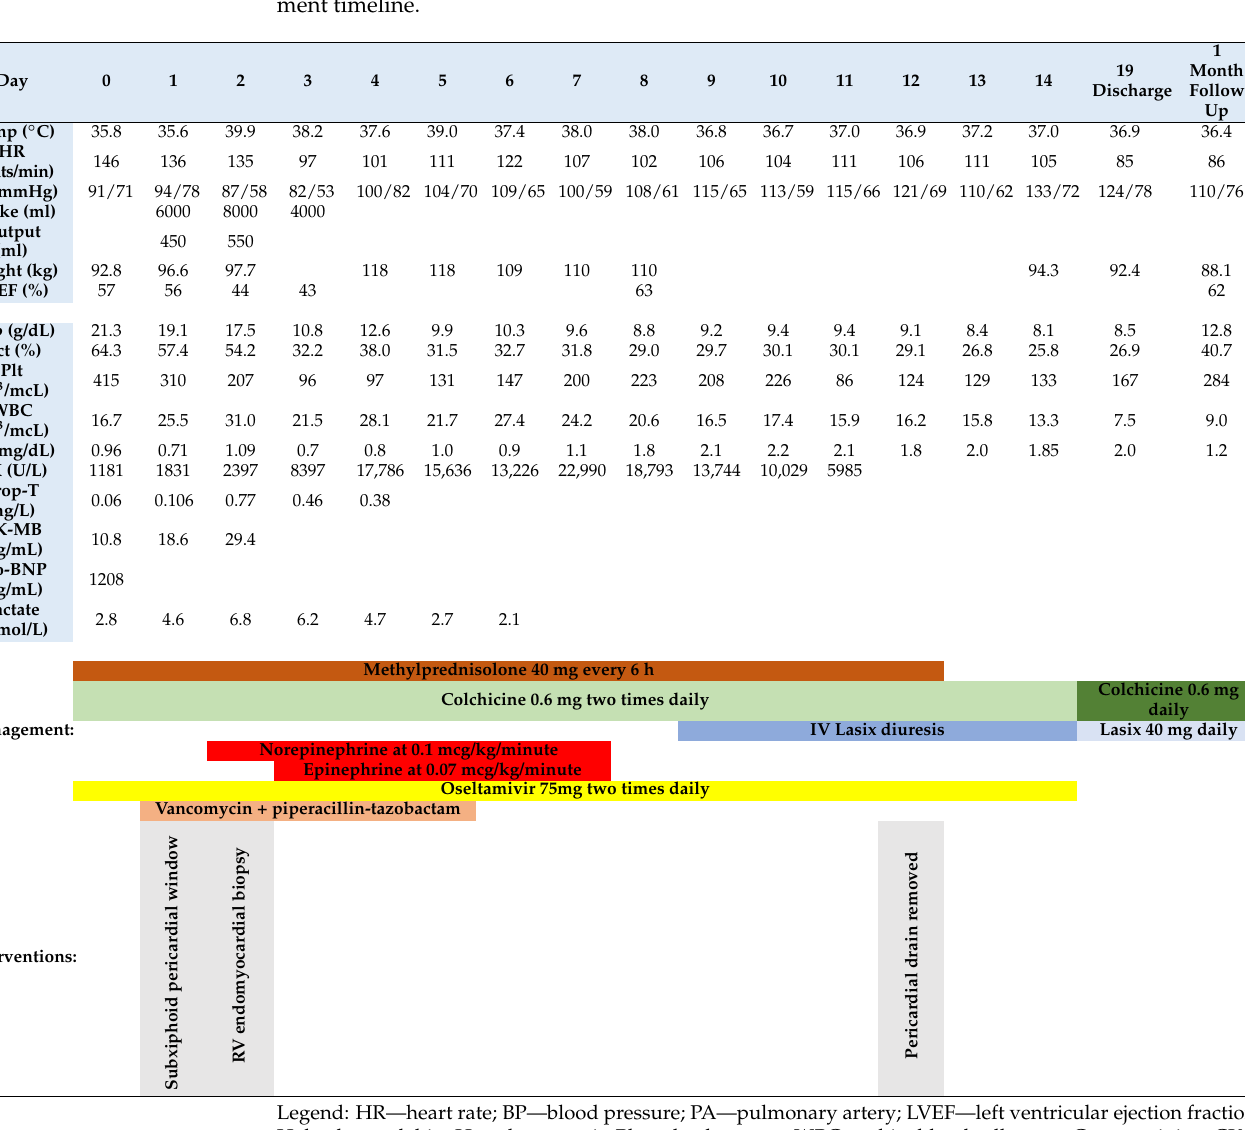
Table 1. Daily vital signs, hemodynamic parameters, pertinent laboratory findings, and treat- ment